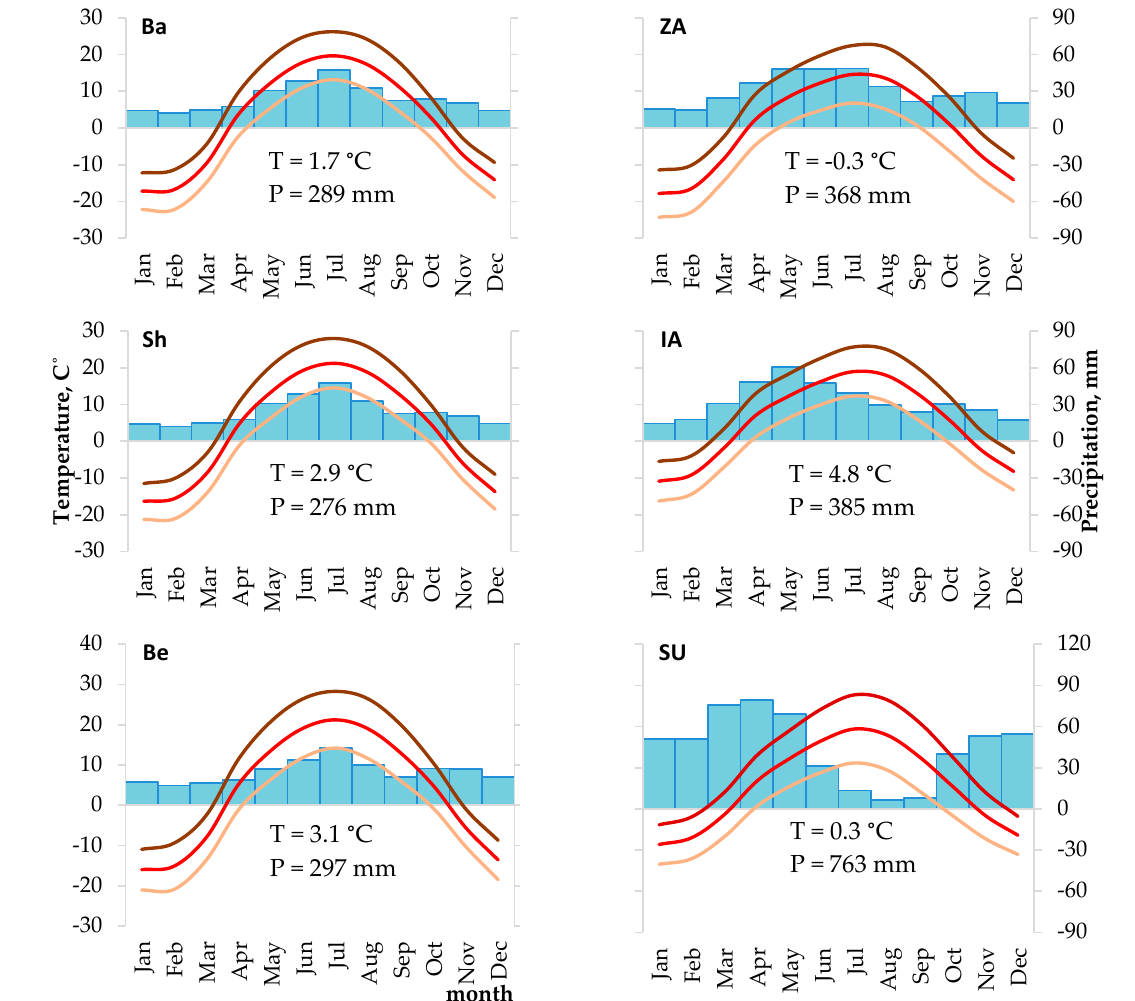
Figure 2. Average monthly climatic characteristics (Climatic Research Unit Time Series, CRU TS 1901–2020) for geographic grid cells where sampling sites are located: Ba—Bayanaul, Sh—Shalday, Be—Beskaragay, ZA—Zhongar-Alatau, IA—Ile-Alatau, and SU—Sairam-Ugam. Lines represent maximum (dark), mean (medium), and minimum (light) temperatures; bars represent precipitation. Numbers represent the average annual mean temperature (T) and the average annual sum of precipitation (P). Note that at sampling sites located in mountain foothills (ZA, IA, and SU), temperatures are probably higher than the values for mountainous areas that are presented here (cf. Figure A2).